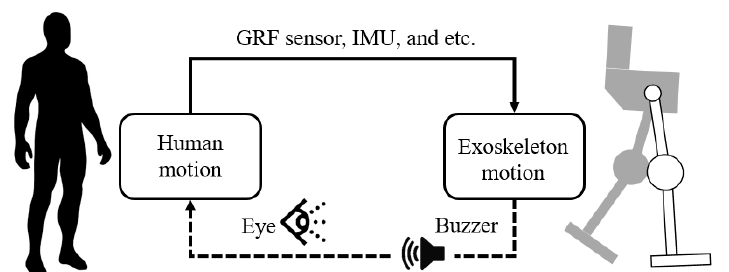
Figure 4. The applied human–machine synchronization concept. The exoskeleton system detects human motion using several sensors, but the person can indirectly detect the exoskeleton’s motion by the buzzer sound and visual feedback.